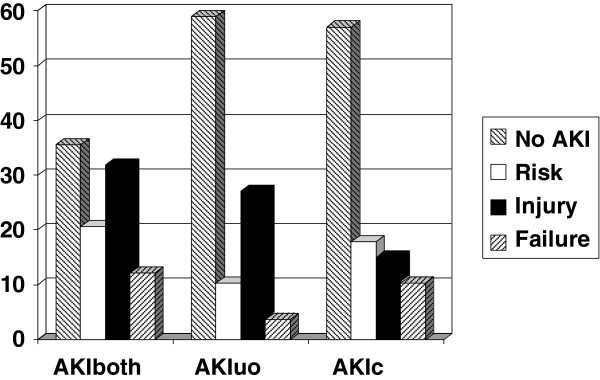
Distribution of RIFLE class based on a single or both criteria. Based on the urinary and the creatinine criteria together (AKIboth), 35.5% of patients had no AKI, versus 20.6%, 31.8%, and 12.1% with RIFLE R, I, and F. Based on the urinary output criterion only (AKIuo), 58.9% patients were classified as having no-AKI, versus 10.3%, 27.1%, and 3.7% as RIFLE-R, I, or F, respectively. Based on the creatinine criterion only (AKIc), 57% had no AKI, versus 17.8%, 15%, and 10.3% classified as RIFLE R, I, and F (P < 0.03).